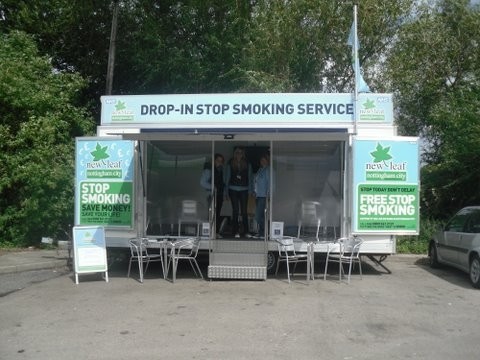
Image of the MSSS.